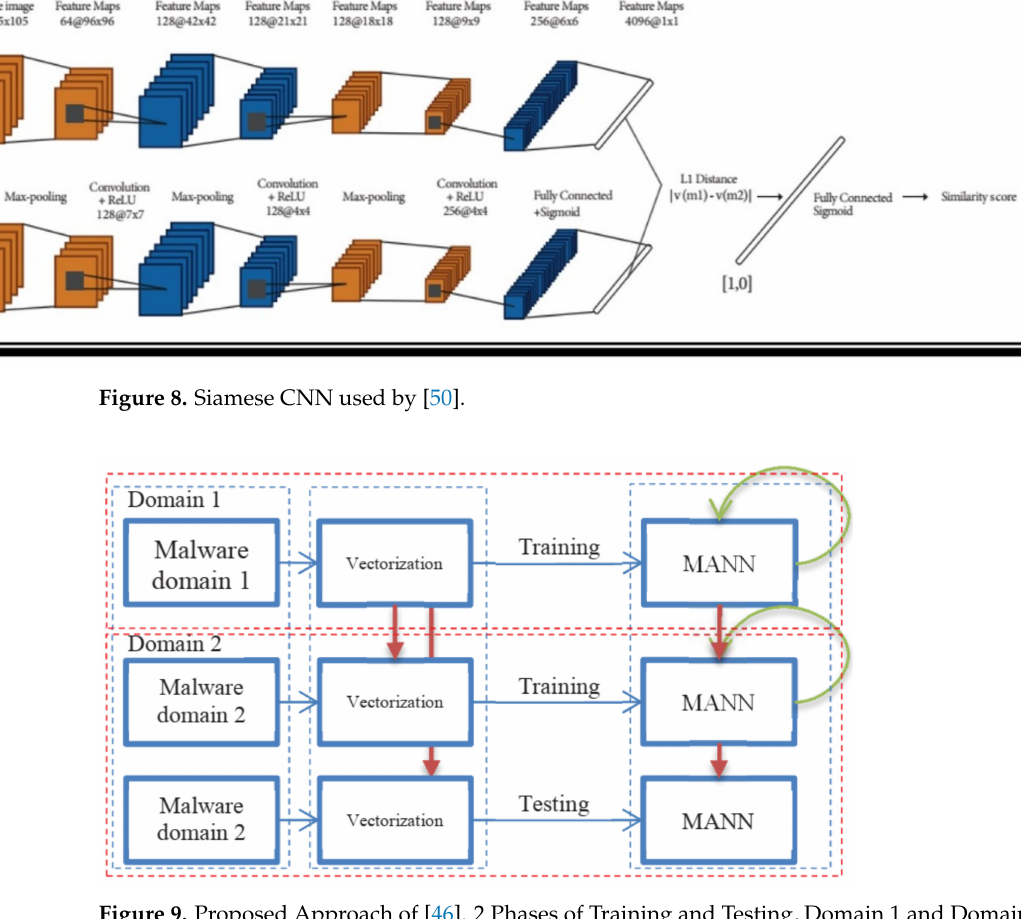
Figure 9. Proposed Approach of [46]. 2 Phases of Training and Testing, Domain 1 and Domain 2.